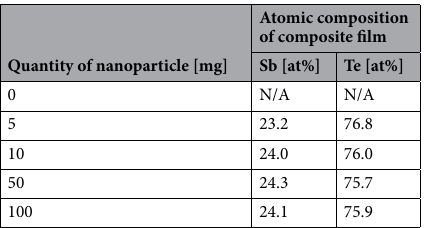
Table 1. Atomic composition of SWCNT films with nanoparticles, followed by electrodeposition.